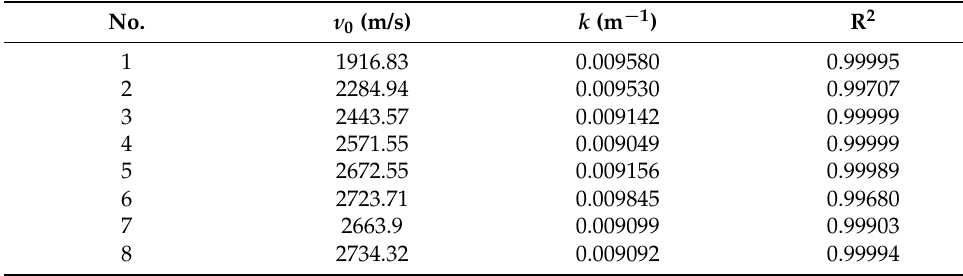
Figure 9. Distance − velocity fi tt ing curve.